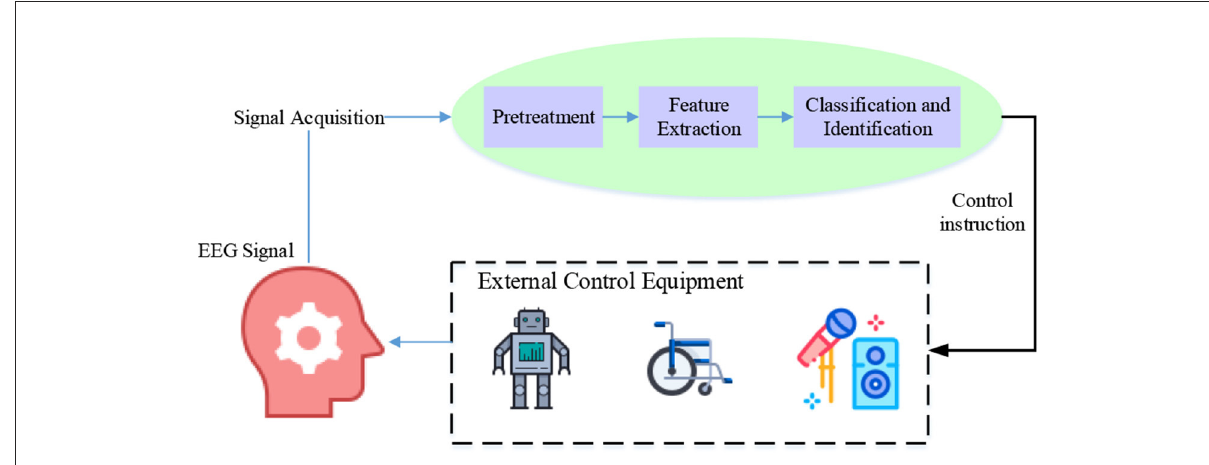
FIGURE2 BCI technical workflow.